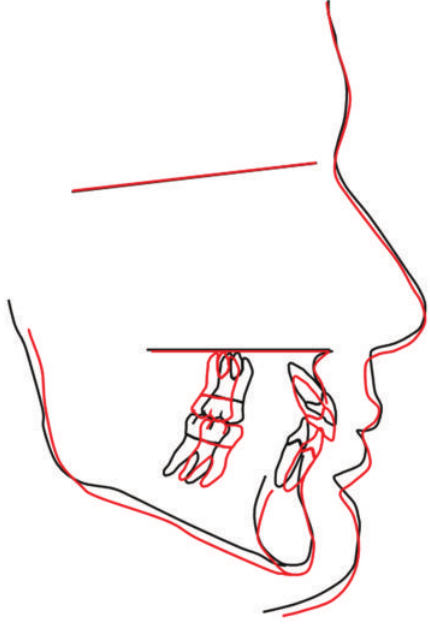
Figure 7: Superimposition of pre- and posttreatment cephalometric